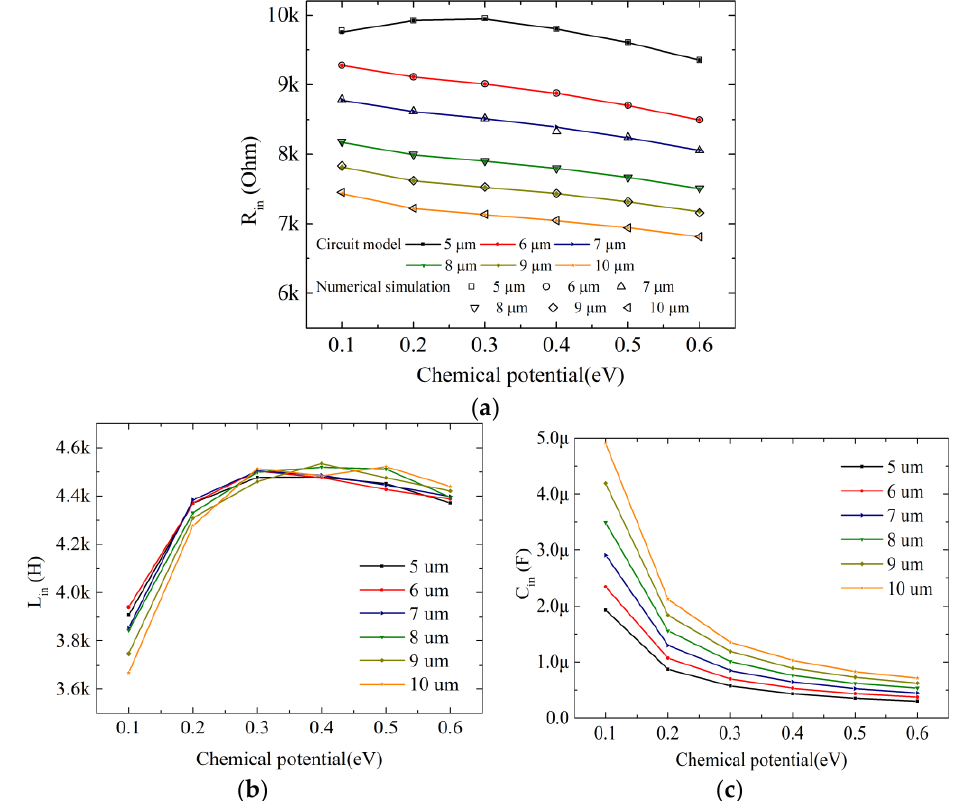
Figure 5. Equivalent circuit parameters. ( a ) R in , ( b ) L in , and ( c ) C in of the equivalent circuit against chemical potential with different arm lengths. The solid lines are the results from the equivalent circuit model and the scatter denotes the numerical data. The relaxation time is 0.5 ps and the temperature is 300 K.